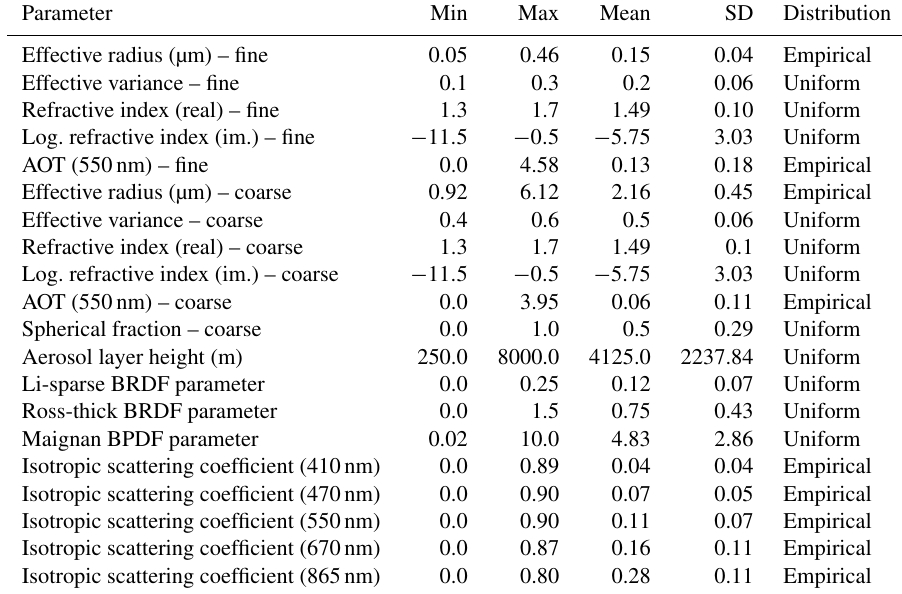
Table 1. Details of the statistical distributions of the aerosol and surface parameters used to generate the training data set. Please refer to Figs. 2 and 3 for the histograms of the distributions indicated as “empirical”.